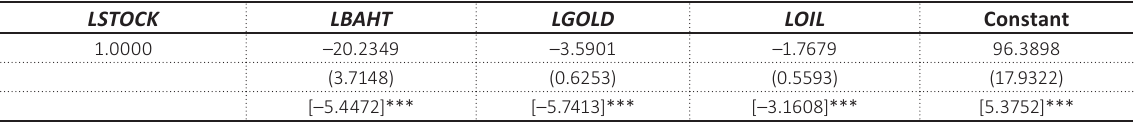
Table 4. Normalized cointegrating coefficients